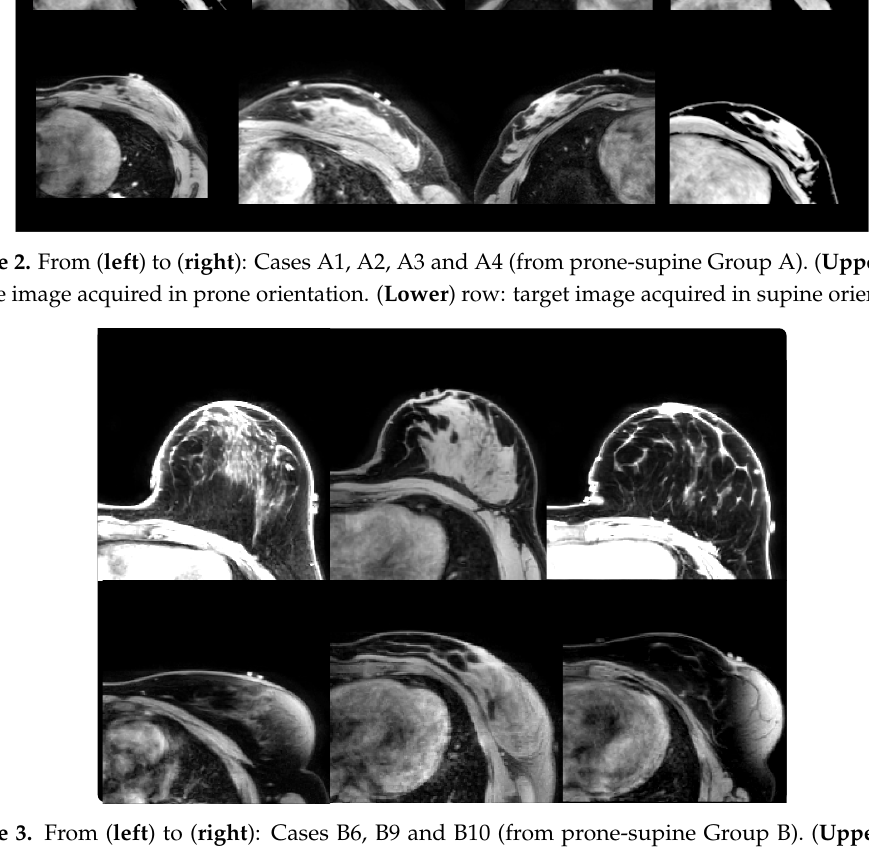
Figure 3. From ( left ) to ( right ): Cases B6, B9 and B10 (from prone-supine Group B). ( Upper ) row: source image acquired in prone orientation. ( Lower ) row: target image acquired in supine